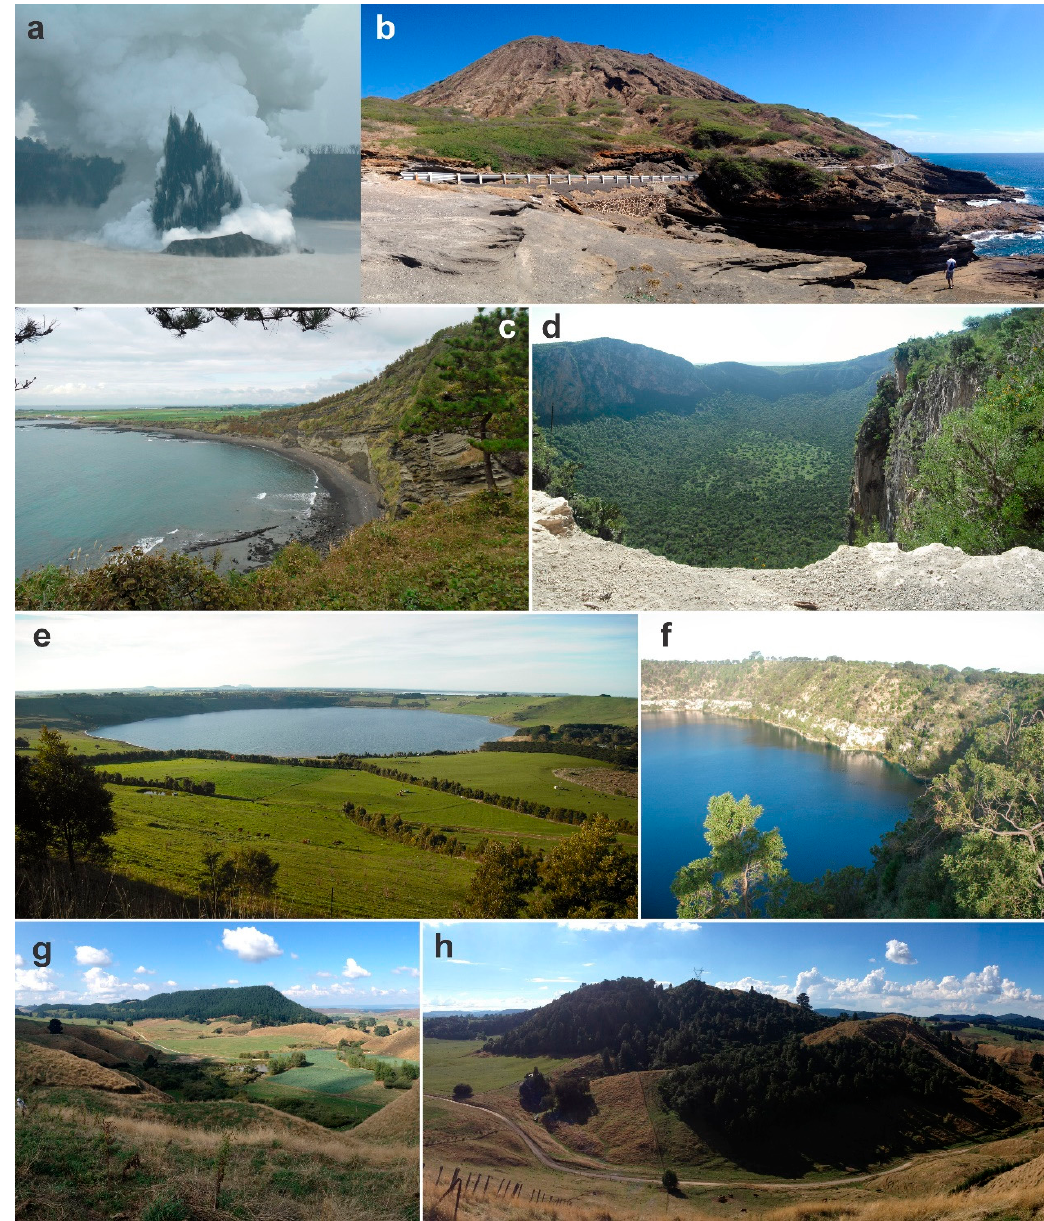
Figure 3. Geomorphology of typical volcanoes formed under the dominance of explosive hydrovolcanic activity: ( a ) – Eruption cloud with a small emergent pyroclastic cone captured during the December 2005 Surtseyan-style intra-caldera eruption in the caldera lake on top of Ambae, Vanuatu; ( b ) – Gully erosion on the steep upper edifice of Koko Crater tuff cone with coastal section of pyroclastic surge deposits, Ohau, Hawaii, USA; ( c ) – A typical tuff ring showing low angle tephra ring around a crater that has a crater floor (photo is taken from the crater floor) above the syn-eruptive surface (Songaksan tuff ring in Jeju Island, South Korea); ( d ) – A maar cut into the syn-eruptive surface deeply at the Blue Lake at Mount Gambier in South Australia. Note the bright, white rocks exposed just above the water level marking the exposed country rocks below the tephra rim and above the crater floor and lake level; ( e ) – Shallow maar with a flooded maar basin (Lake Gnotuk, Victoria, Australia), which has its crater floor slightly below the syn-eruptive surface. The maar is surrounded by thin tephra ring; ( f ) – Nearly 300 meters deep maar crater of the Joya Honda Maar, San Luis Potosi, Mexico; Coalesced maar craters relating to the initial fissural phase of a rhyolitic dome forming eruption ( g ) and a lava dome that surrounded by an atypical tuff ring comprising block-and-ash flow deposits among more typical fall and surge beds ( h ), Puketerata Volcanic Complex, Taupo Volcanic Zone, New Zealand.